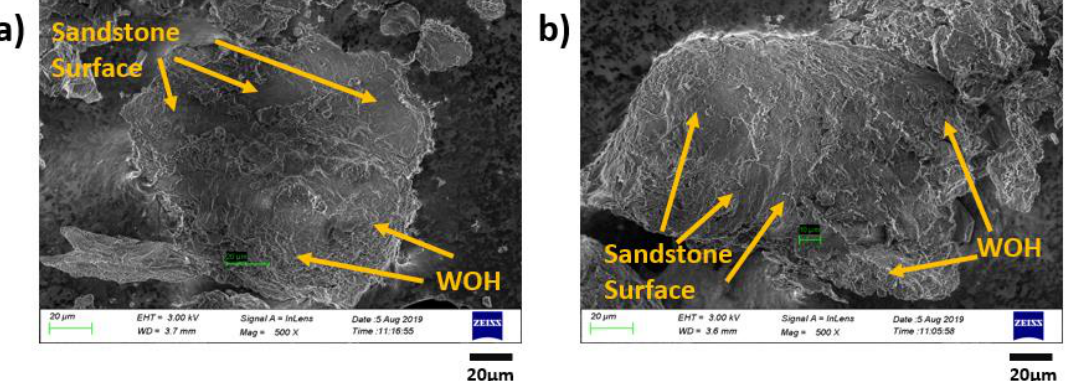
Figure 14. Demonstration of the aggregate in the composites prepared with remolded Pisha aggregate (R-P-1 Type) and original polyurethane with 8% concentration. ( a ) and ( b ) Indication of the local structure for the composites prepared with remolded Pisha aggregate (R-P-1 Type) and original polyurethane with 8% concentration.